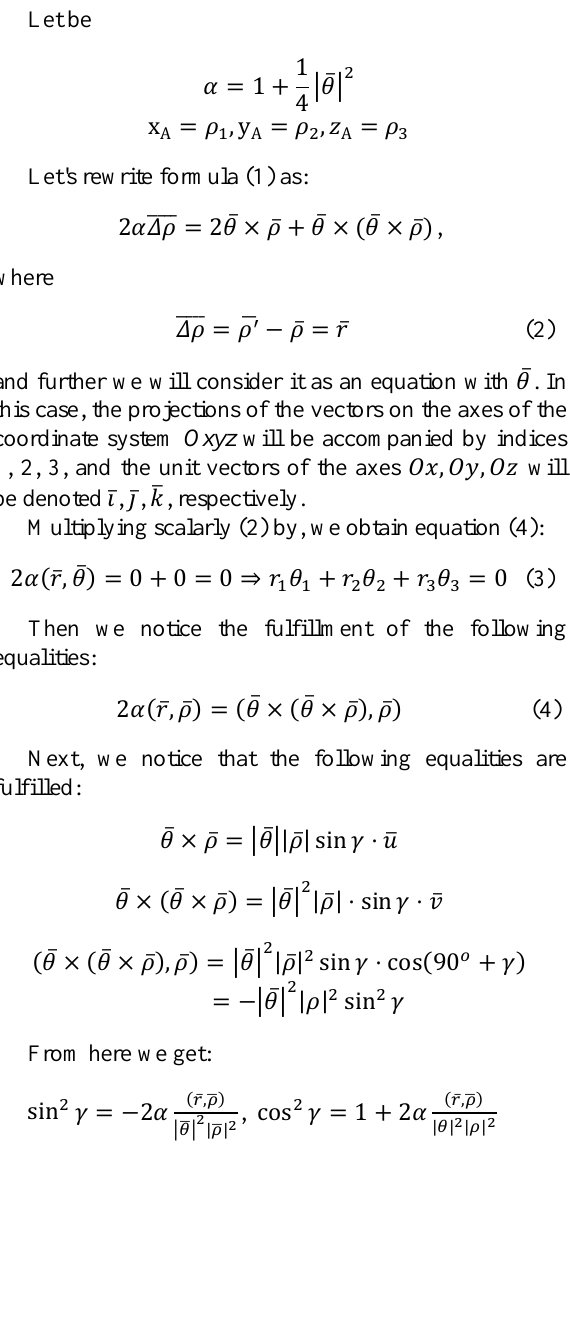
Fig. 2. Rodrigues' rotation formula